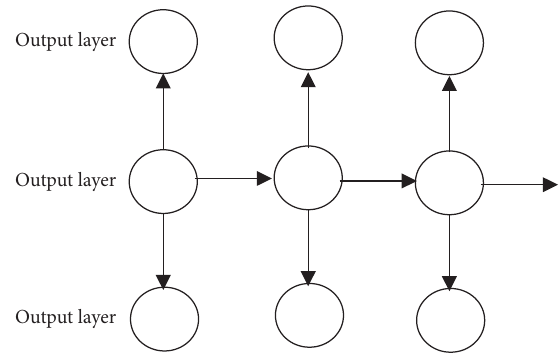
Figure 9: A simple RNN structure.